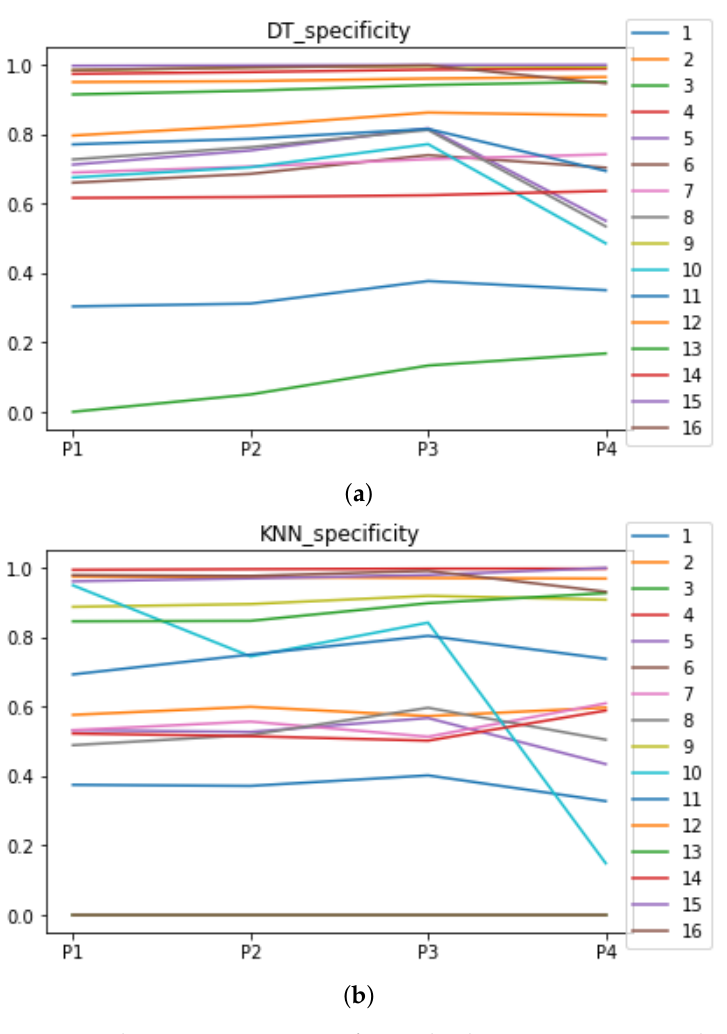
Figure A5. Behavior RHOASo: specificity. The datasets are represented with a bar chart for each partition. ( a ) Specificity for DT. ( b ) Specificity for KNN.